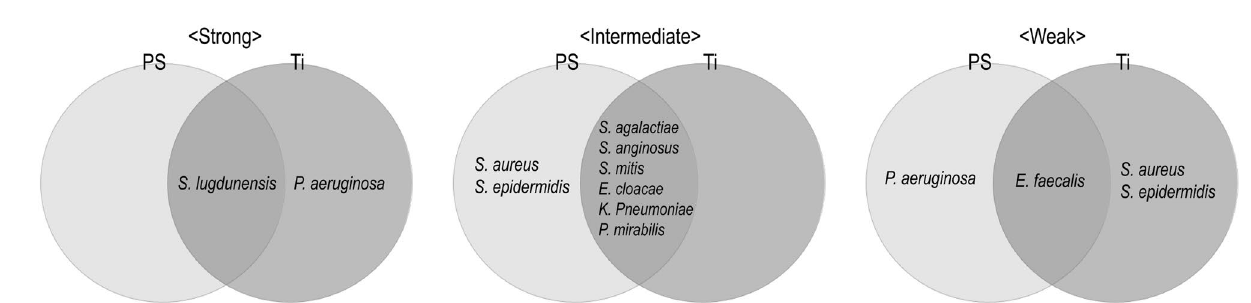
Figure 4. Comparison of biofilm-forming abilities on PS and Ti. The Venn diagram compares the biofilm- forming ability of each microorganism on PS or Ti according to its classification on each